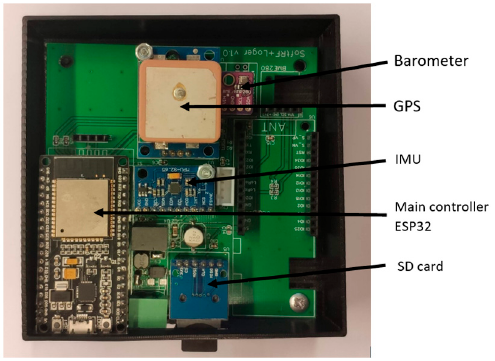
Figure 3. Data acquisition unit.